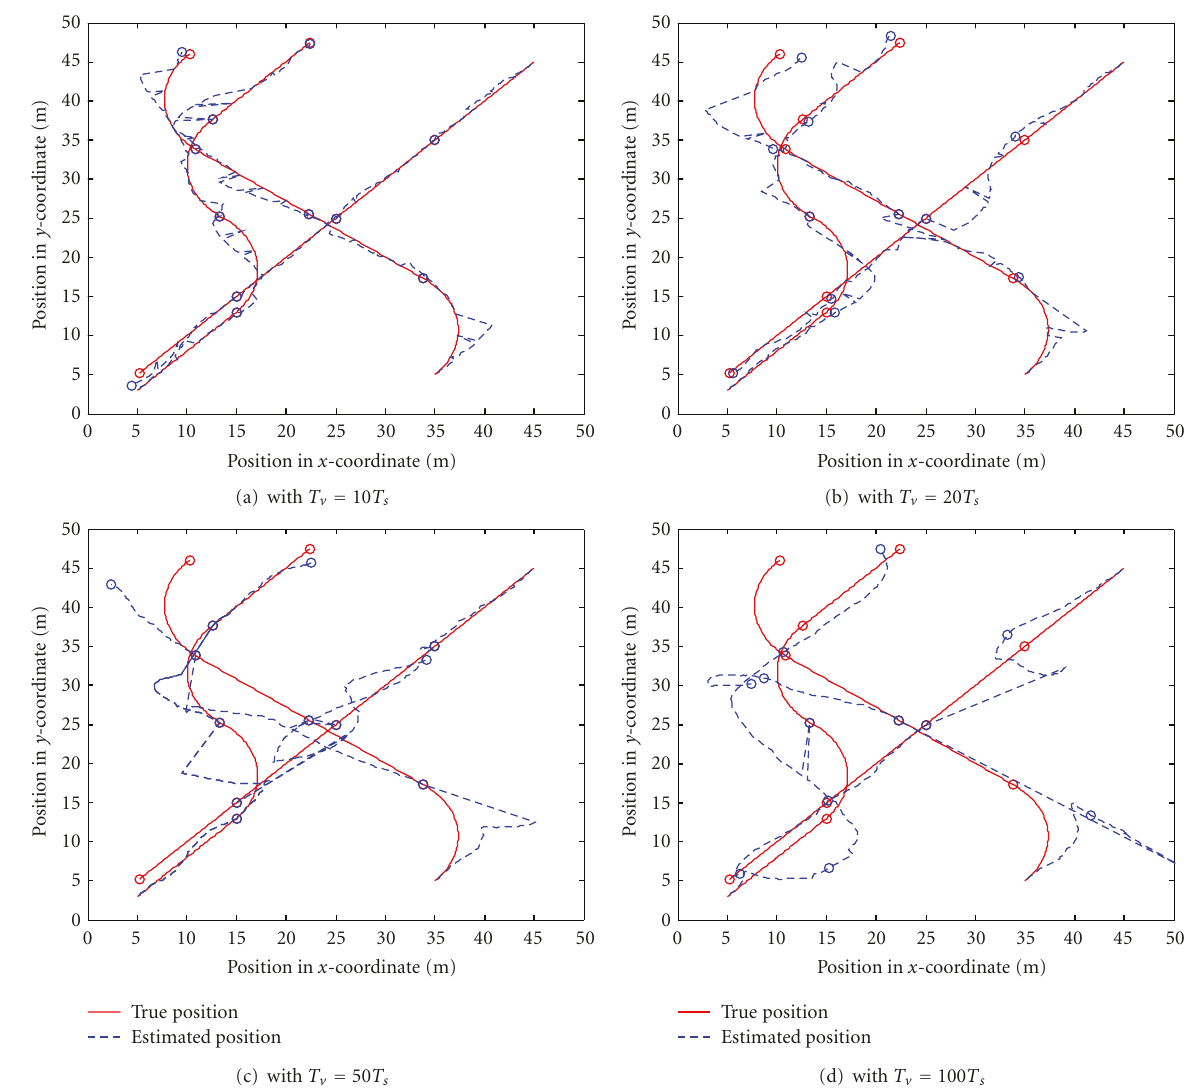
Figure 4: Visual sensor cooperation performance for periodic cooperations with T v : 10 T s , 30 T s , 50 T s , and 100 T s based on the result with measurement variance 5.0 in Figure 3(d) (500 particles are used in the